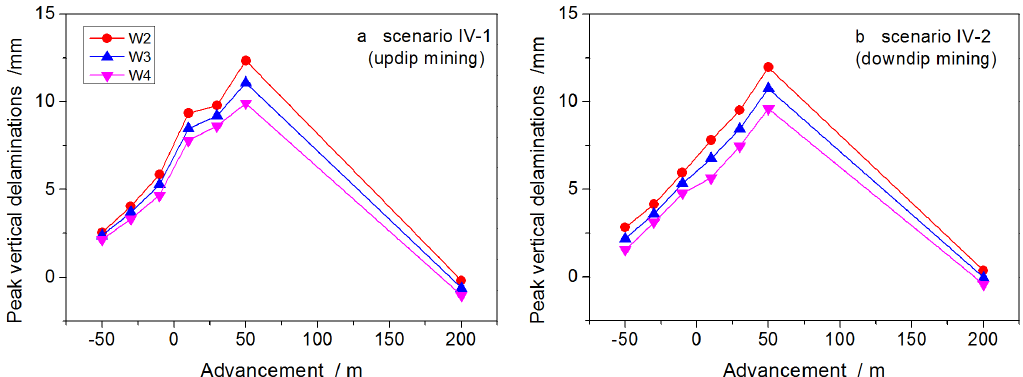
Figure 17. Dynamic evolution of peak vertical delaminations along well trajectories W2–W4 as the longwall panel advances ( a ) updip ( b ) and downdip. The abscissa represents the horizontal distance between the well and the working face after each stage of excavation. Negative magnitudes indicate that the advancing face is ahead of the well and positive magnitudes indicate that the face has passed the well.